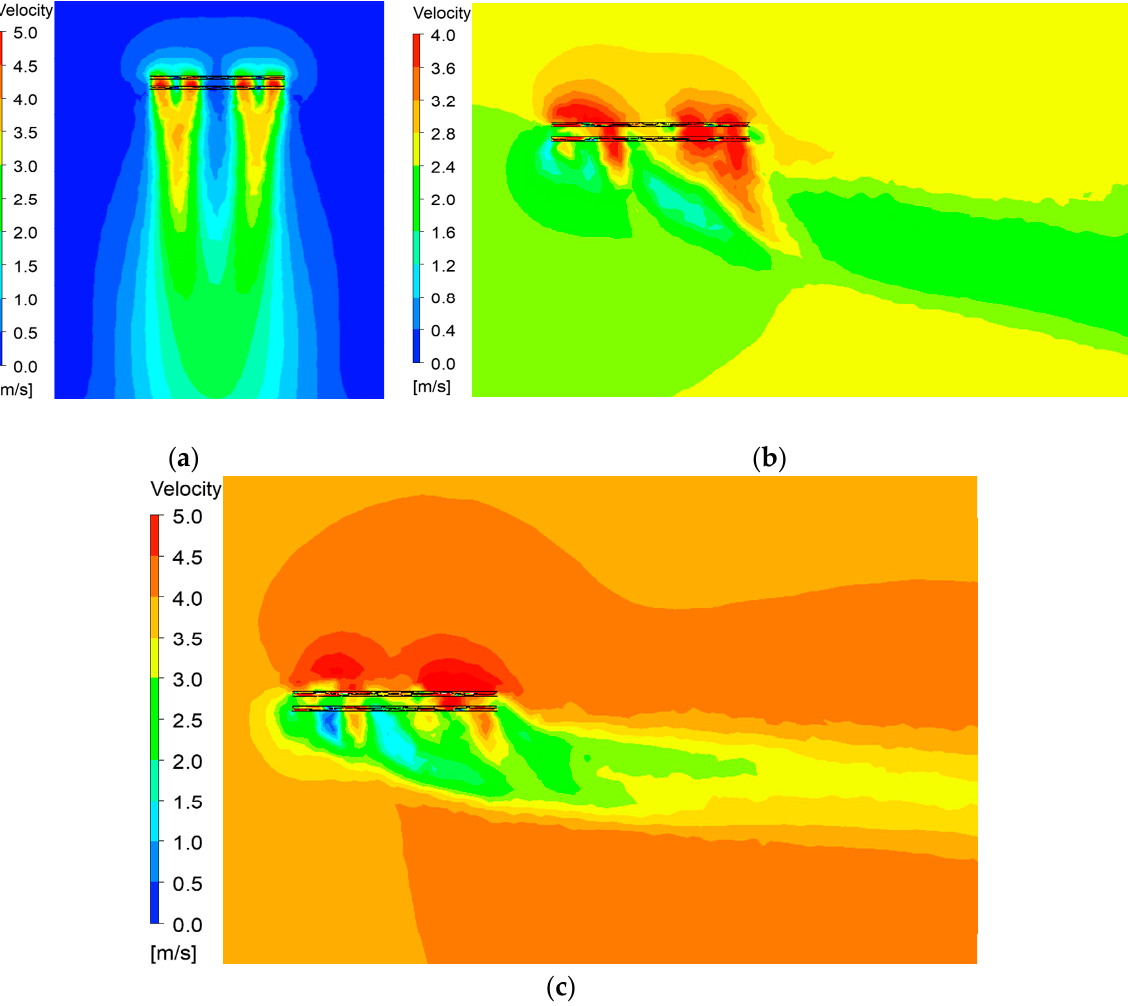
Figure 11a Figure 9. The velocity contour of coaxial Tri-rotor (2200 r / min): ( a ) 0 m / s; ( b ) 2.5 m / s; ( c ) 4 m /